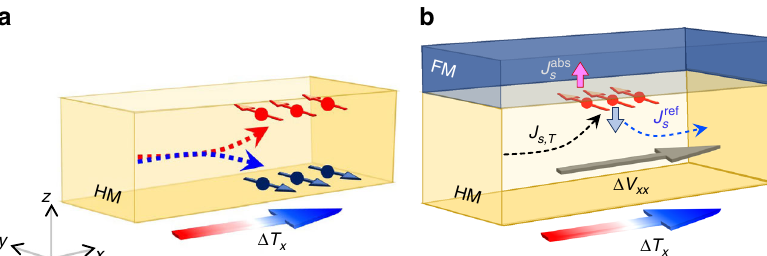
Fig. 1 Schematics for spin Nernst effect and spin Nernst magnetoresistance. a Spin Nernst effect (SNE), where the temperature gradient in x -direction generates a spin current in z -direction with the spin orientation in y -direction. b Spin Nernst magnetoresistance (SNMR) in FM/HM bilayer where a spin current induced in HM by a temperature gradient in x -direction ( J s , T ) partially re fl ected at the FM/HM interface depending on its spin orientation with respect to the magnetization direction of the FM layer, resulting in the modi fi cation of the longitudinal ( Δ V xx ) and transverse ( Δ V xy ) thermoelectric voltages of the bilayer. J abs s ( J ref s ) is the absorbed (re fl ected) spin current at the FM/HM